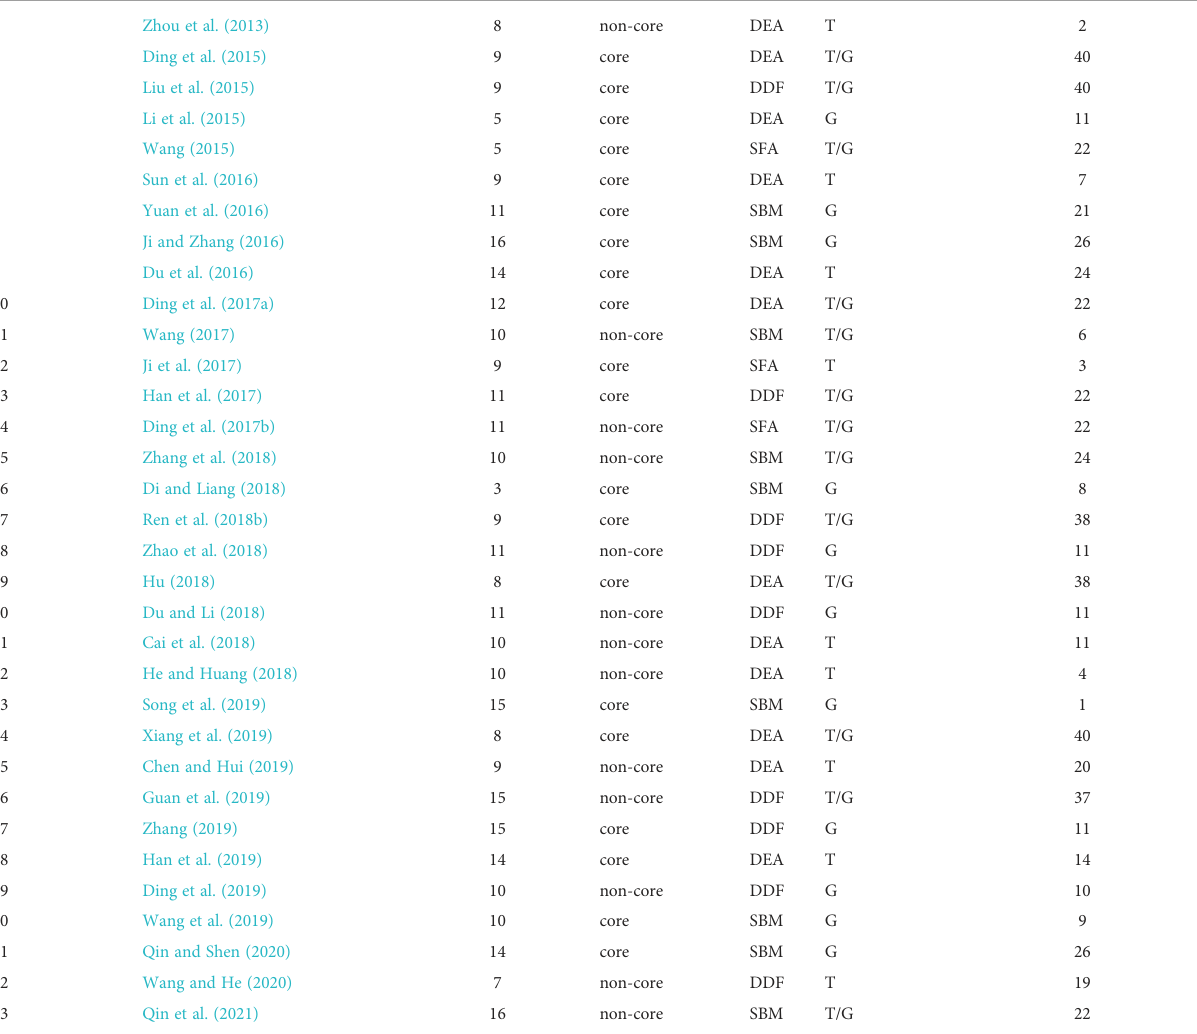
TABLE 1 Summary statistics of the primary studies used in